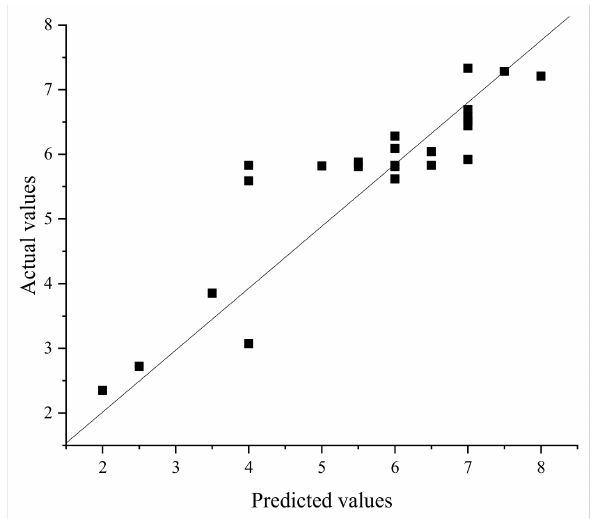
Figure 20. Comparison of predicted and actual values by NAA (r 2 =